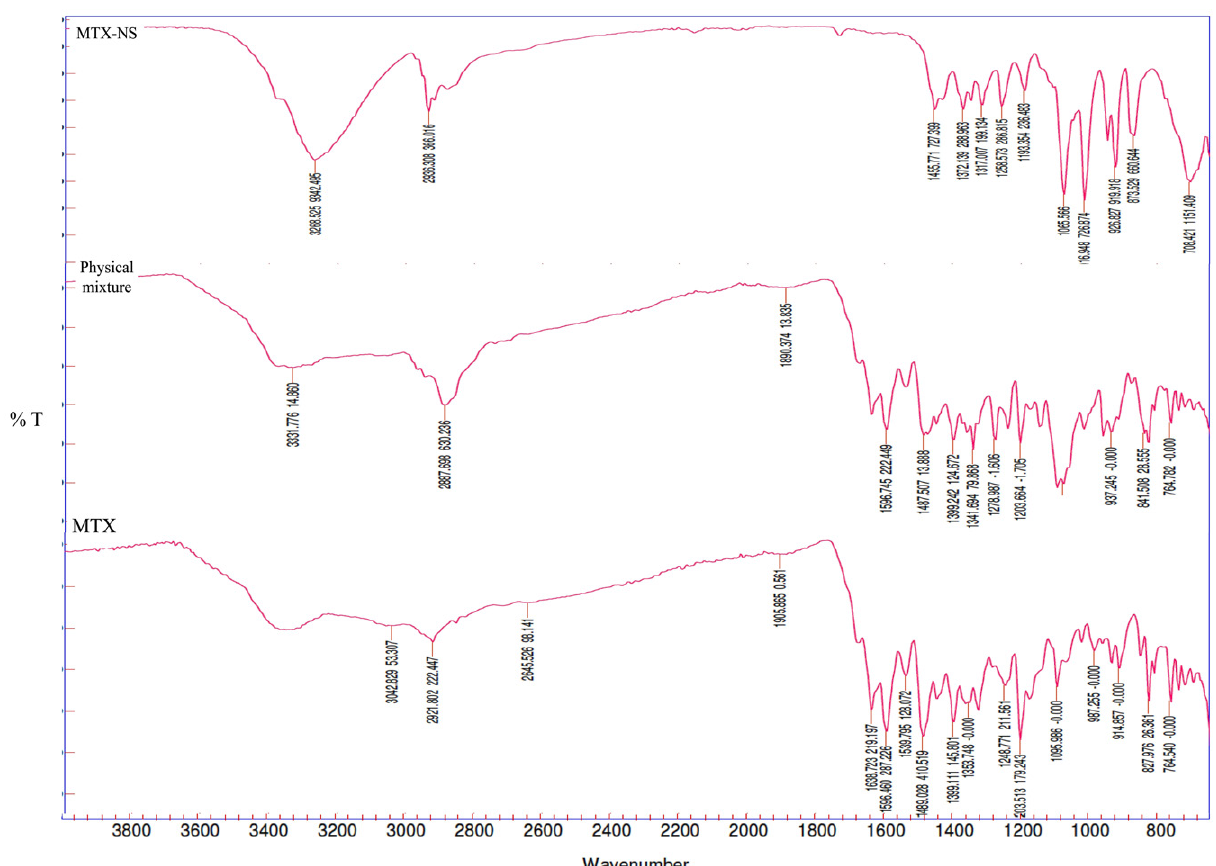
Figure 8. FTIR spectrum of A) pure MTX B) optimized NS(MTX-NS) and C) physical